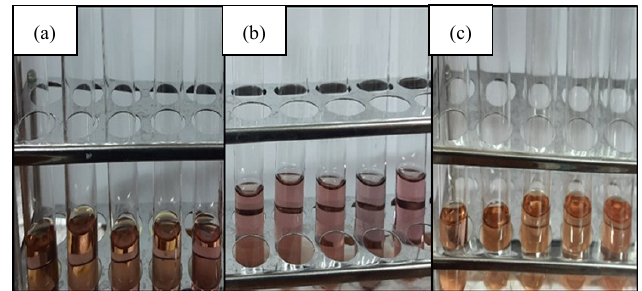
Fig. 10. DPPH Assay of the standard Vit. C